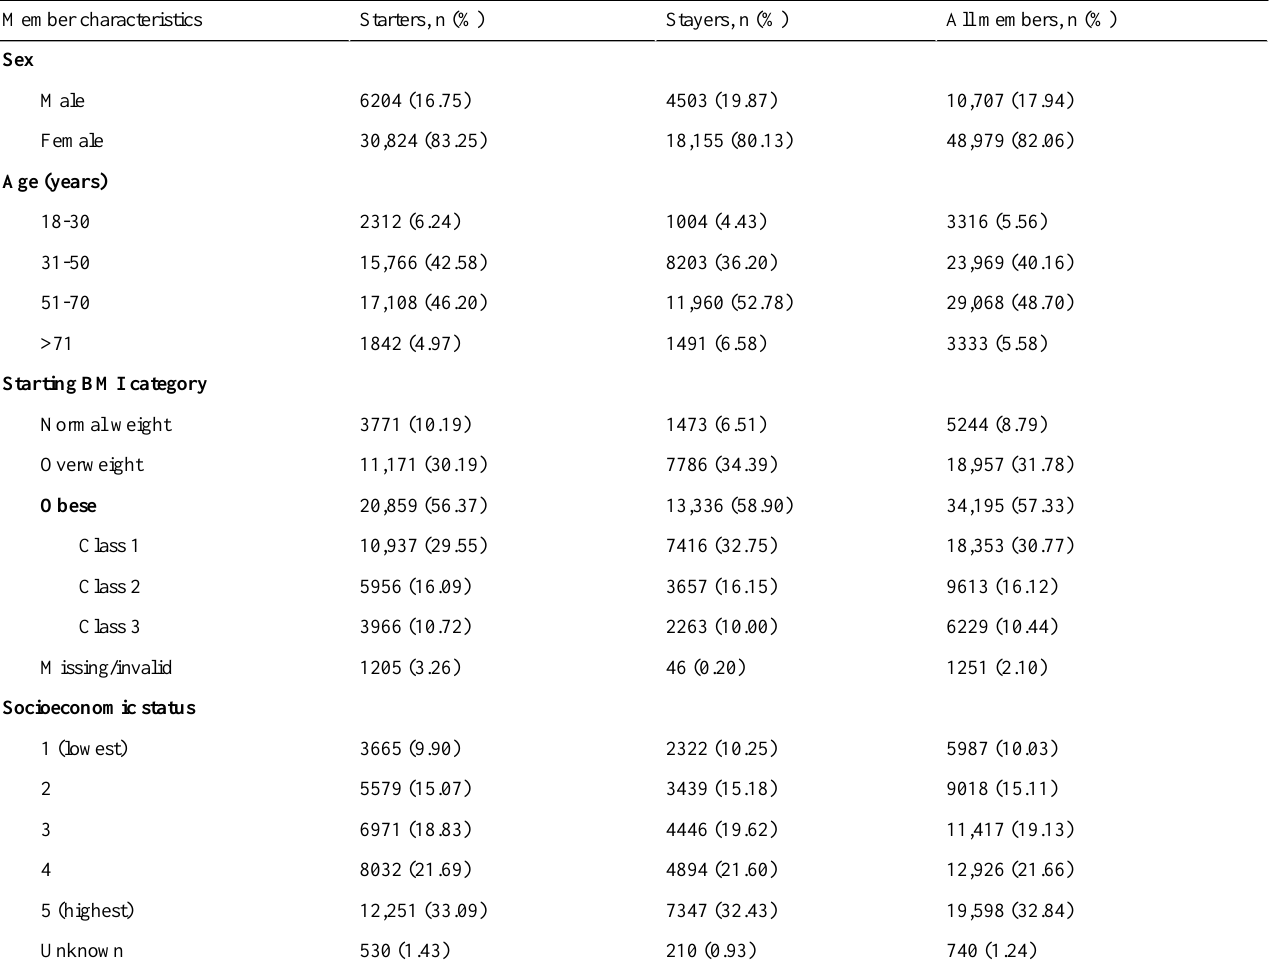
Table 1. Demographic characteristics of starters (n=37,028), stayers (n=22,658), and all members (N=59,686) at the time of joining the CSIRO Total Wellbeing Diet Online.